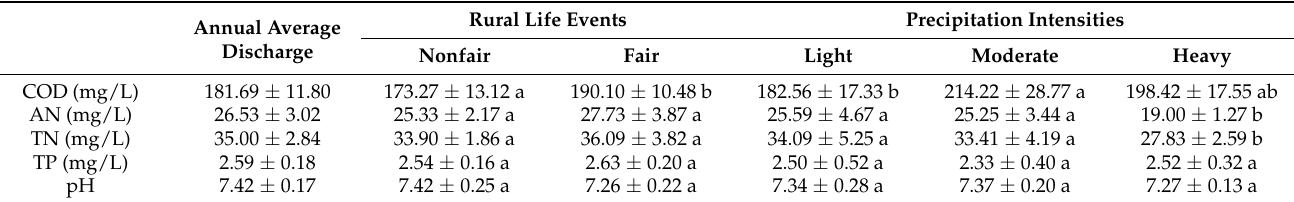
Table 1. Discharge characteristics of domestic